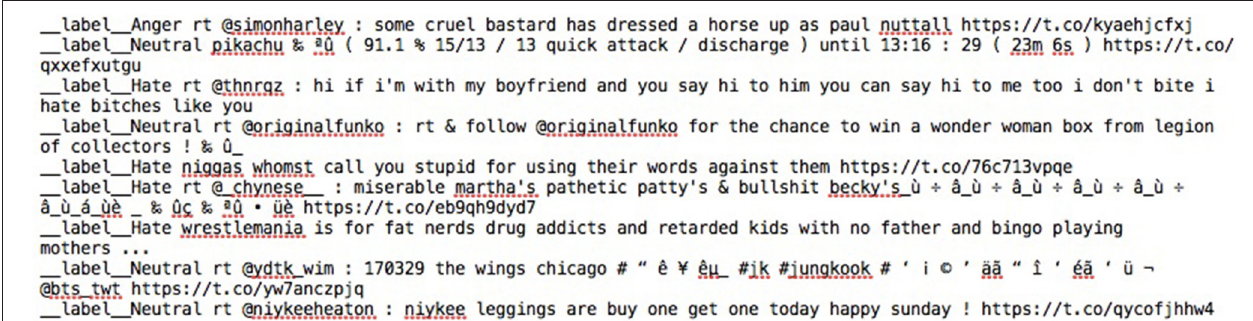
FIGURE 2 | A screenshot of the file used for the training of the fasttext classifier.